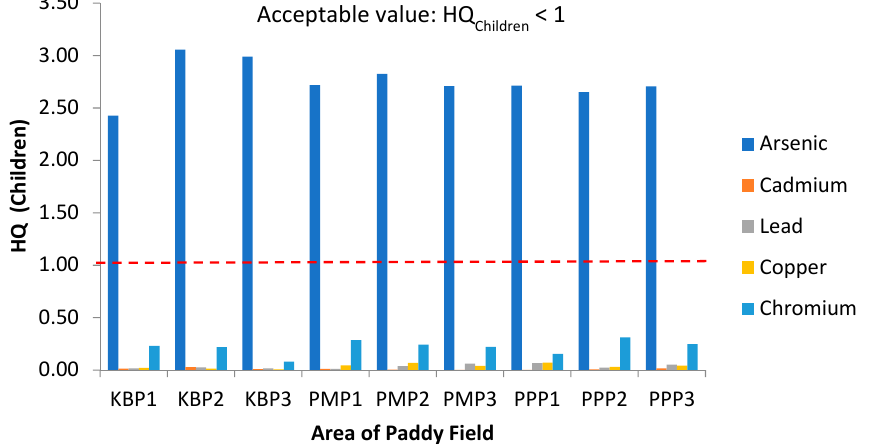
Figure 8. Hazard Quotient (HQ) values for children via intake of rice from the three plots of sampling sites. KBP1: Kota Bharu Plot 1, KBP2: Kota Bharu Plot 2, KBP3: Kota Bharu Plot 3, PMP1: Pasir Mas Plot 1, PMP2: Pasir Mas Plot 2, PMP3: Pasir Mas Plot 3, PPP1: Pasir Puteh Plot 1, PPP2: Pasir Puteh Plot 2, and PPP3: Pasir Puteh Plot 3.